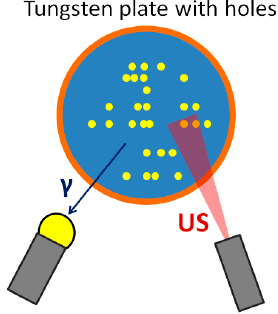
Figure 12. Set-up of the Tungsten-based identifier.